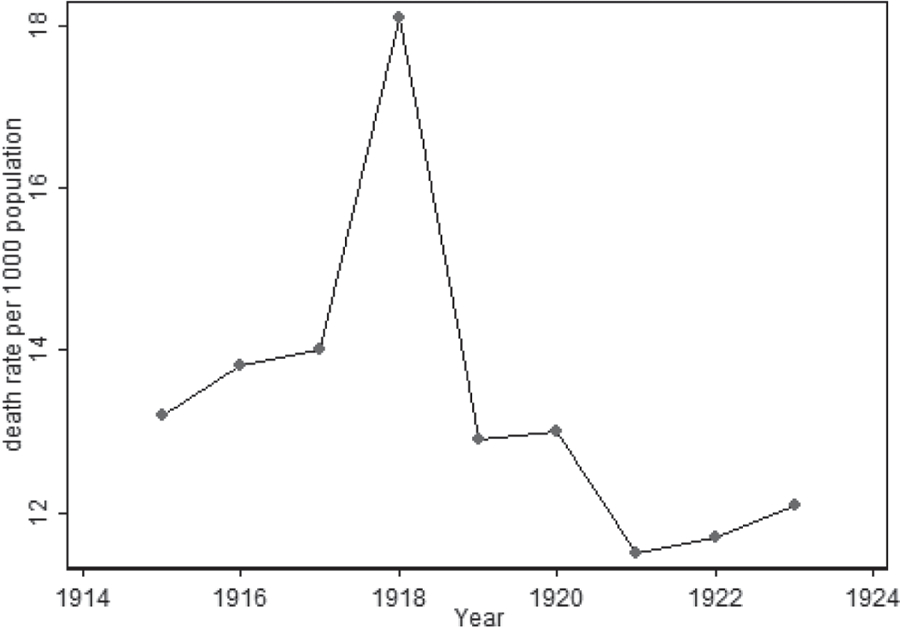
Crude death rate (per 1000 population), by calendar year in the United States. Source:
Bureau of the Census 1943